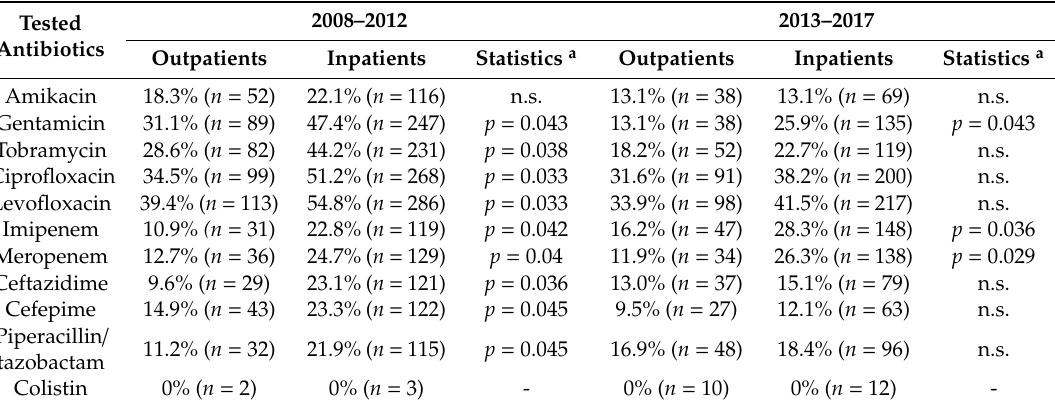
Table 2. Percentage of resistant Pseudomonas strains to relevant antibiotics from inpatient and outpatient departments